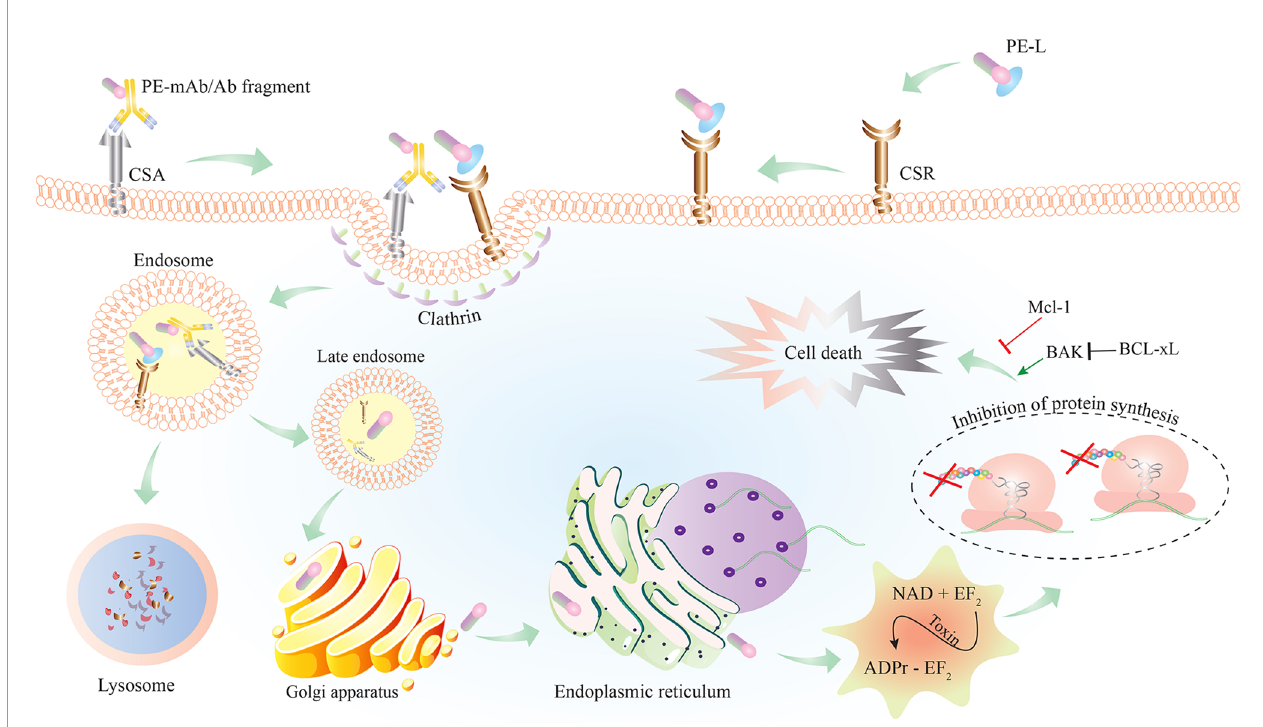
FIGURE 2 | Schematic representation of PE – IT interaction with the cancer-speci fi c antigen (CSA) or cancer-speci fi c receptor (CSR) targeted on cancer cells and the subsequent intracellular events resulting in cell death. PE-L, Pseudomonas exotoxin A (PE) fused to a cancer-speci fi c ligand; Ab, antibody; IT,